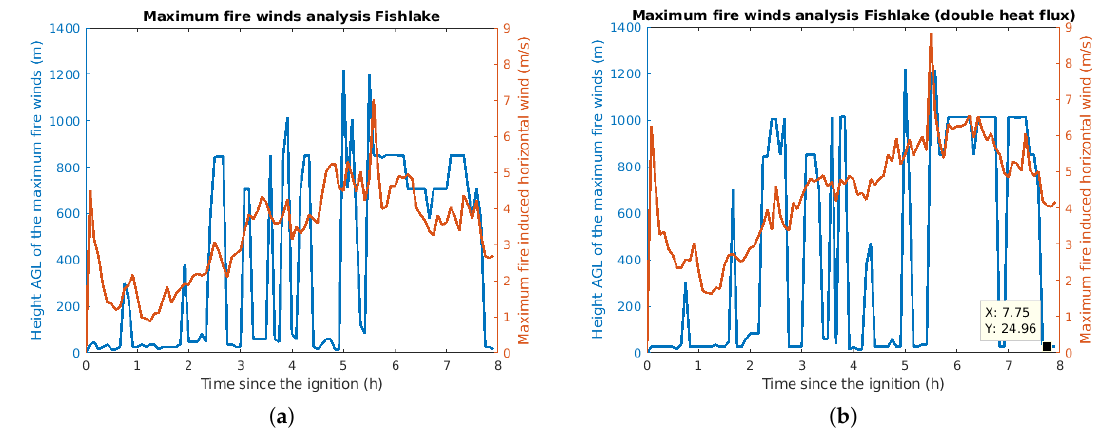
Figure 8. Analysis of the fire-induced winds for the Fishlake simulation executed for 09/03/2014. ( a ) Time series of the maximum fire-induced horizontal winds and their heights in the baseline case; ( b ) Same in the double heat